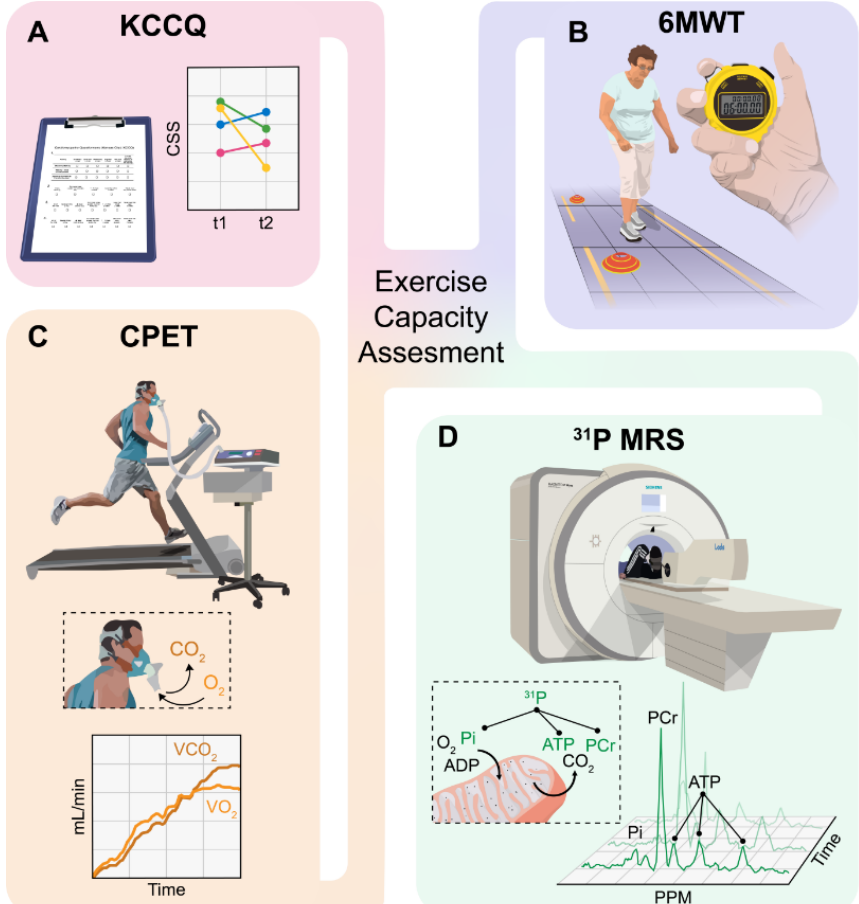
Figure 2. Different tools for the assessment of exercise capacity in heart failure . Abbreviations: ( A ) KCCQ, Kansas City Cardiomyopathy Questionnaire; CSS, clinical symptom score; ( B ) 6MWT, 6-min walk test; ( C ) CPET, cardiopulmonary exercise testing; ( D ) 31P MRS, 31 phosphorus (31P) magnetic resonance spectroscopy; ATP, adenosine triphosphate.